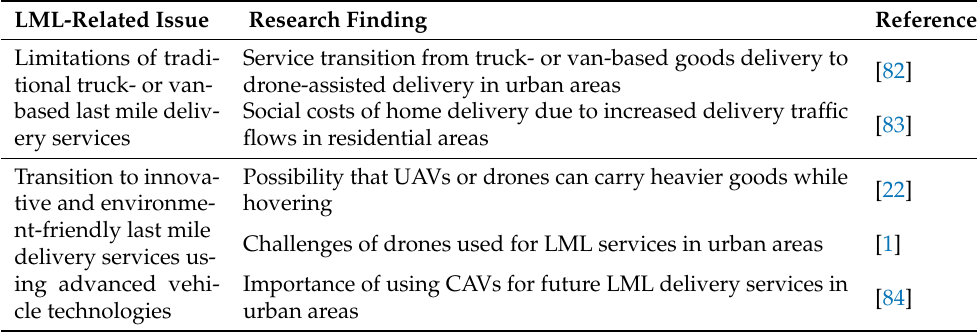
Table 6. LML-related issues and research findings: Delivery technology